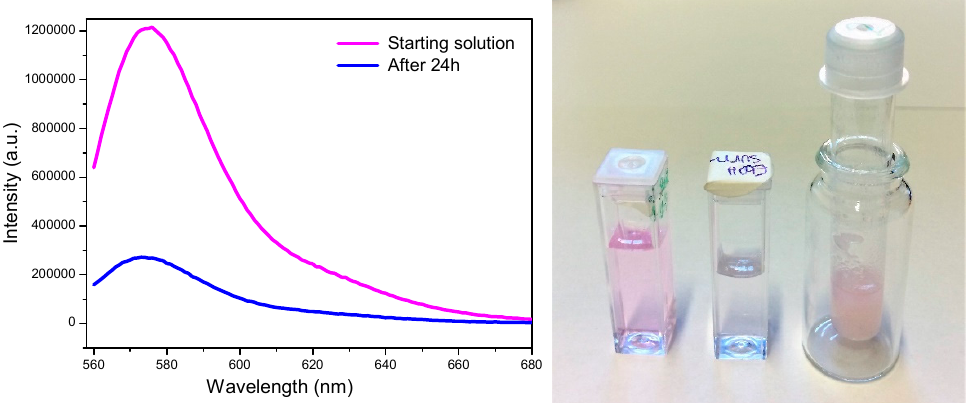
Figure 4. ( Left ) Emission spectra of an aqueous solution of RhB (2.0 µM) (pink) and of the same solution after being treated with the ethanol organogel for 24 hours (blue). ( Right ) Photograph of a fresh sample of the aqueous solution of RhB, of the same sample after treatment with the ethanol organogel, and of the organogel after 24 h (from left to right).